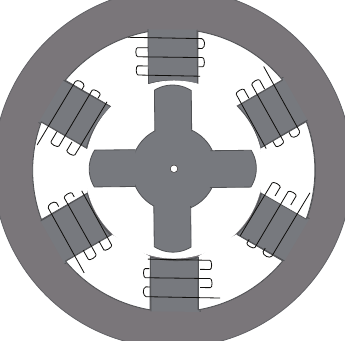
Figure 3. Switched-reluctance motor with variable